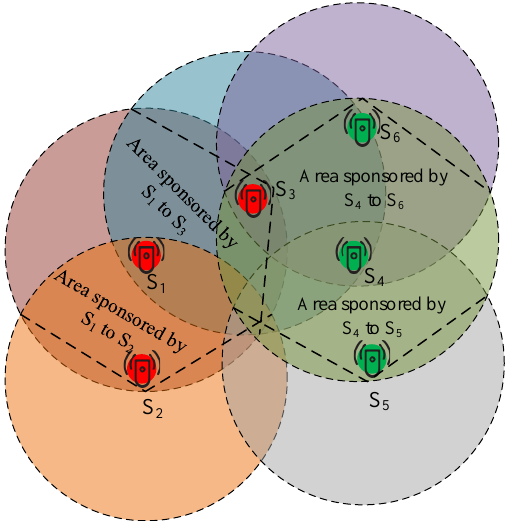
Figure 6. Group of sensors using coverage sponsor centric scheduling for non-overlapping cover- age.